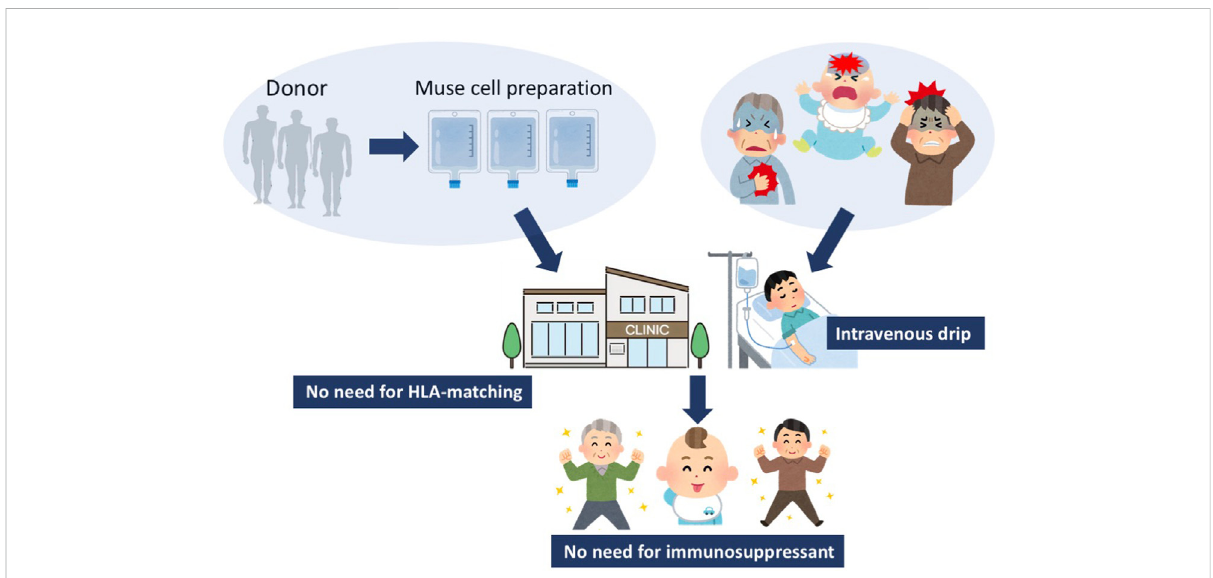
FIGURE 1 StrategyforMusecelltreatment.Musecells,collectablefromdonorsourcessuchastheBM,adiposetissue,andumbilicalcord,areexpandedto produceMusecell preparations,and directly deliveredto patientsbyintravenousdripwithout HLA-matchingtestorimmunosuppressanttreatment. Since Muse cells are pluripotent-like, they might be able to target various kinds of